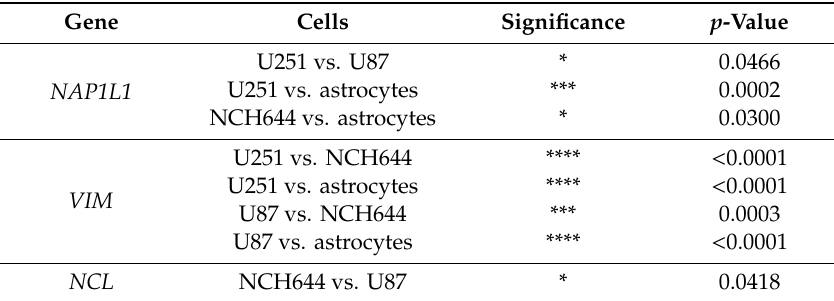
Table 5. Statistical analysis of the qPCR results of the mRNA expression in sEVs. Gene